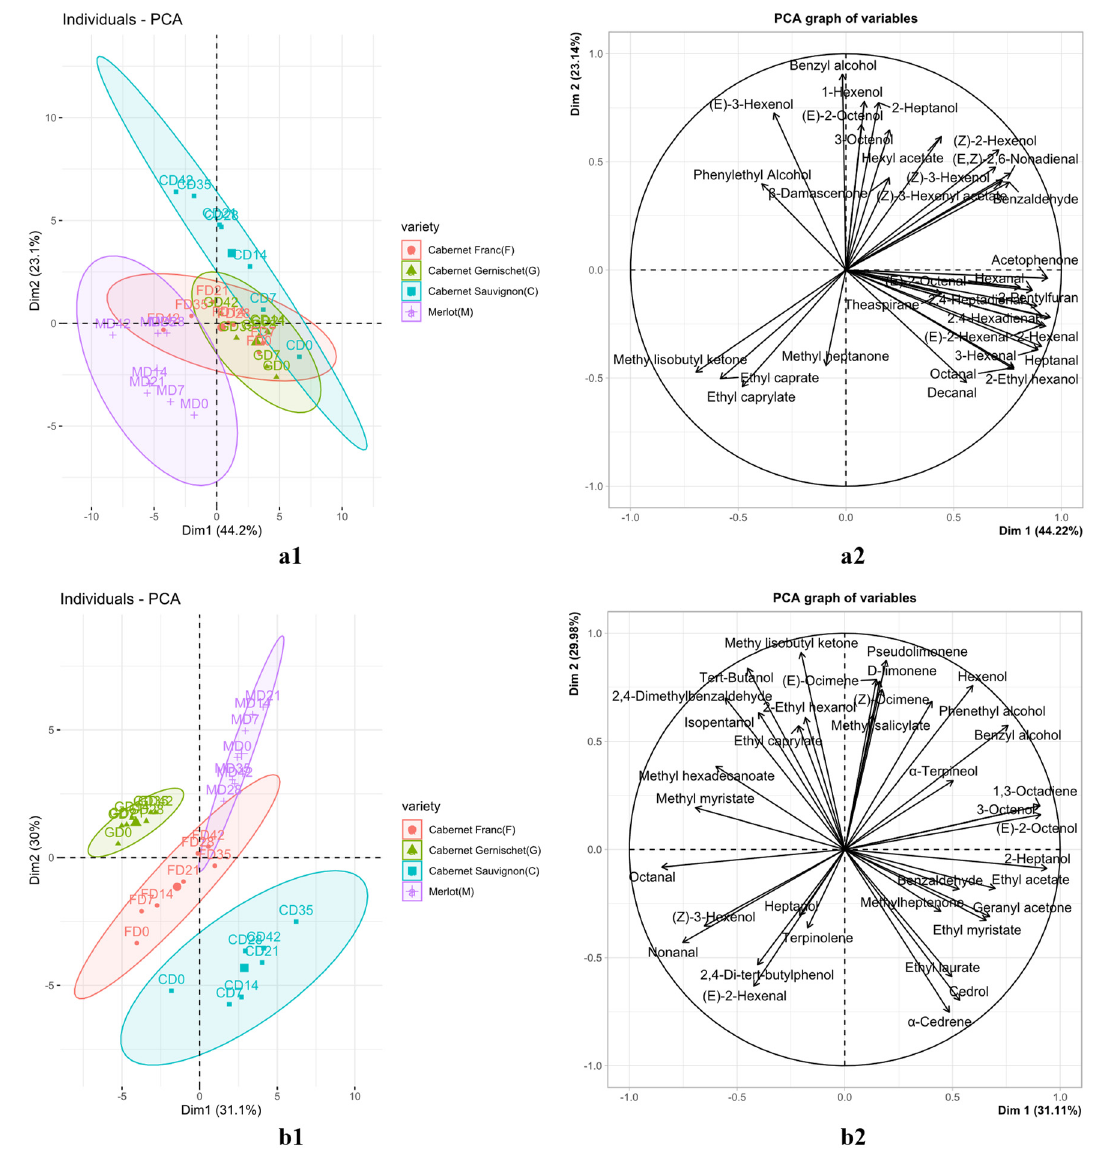
Figure 3. PCA scores plot for samples based on free ( a1 ) and glycosidically bound ( b1 ) volatile compounds of different varieties; PCA loadings plot of free ( a2 ) and glycosidically bound ( b2 ) volatile compounds of different varieties.